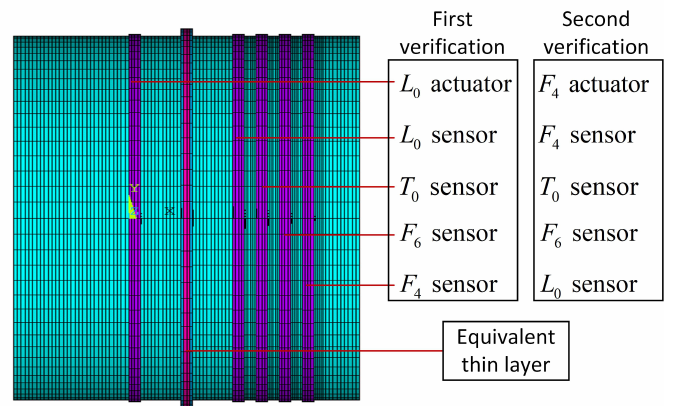
Figure 24. FEM model of drum-flange structure in Section 2. Actuators and sensors are implemented to detected wave-scattering features of joint structure for first and second verification.